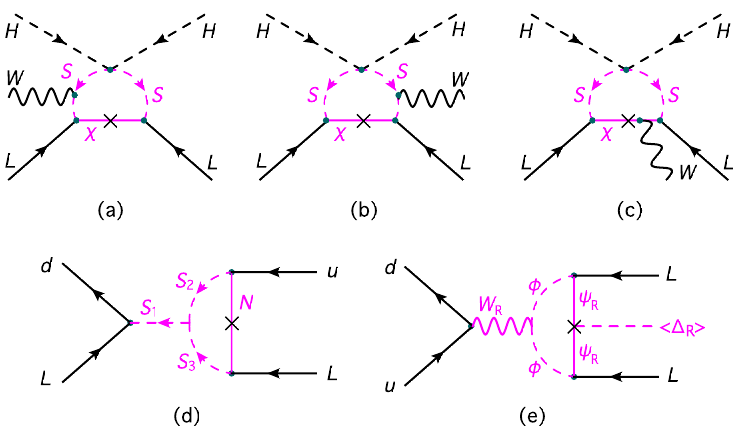
Figure 4 . Feynman diagrams for generating operator O LHW (a-c) in color octet models and operator O (cid:22) in leptoquark models (d) and left-right symmetric models (e). New heavy particles duLLD are highlighted in magenta, and (cid:2) stands for a chirality (cid:13)ip. an odd Z parity to all of S ; S ; N . The gauge covariant derivative for the operator is 2 2 3 formed by attaching a gauge boson line in (cid:12)gure 4(d). This operator can also be realized in left-right symmetric models [70, 71] which have an extended gauge group SU(2) SU(2) (cid:2) U(1) . A concrete example is shown in (cid:12)gure 4(e). Here h (cid:1) R B (cid:0) L